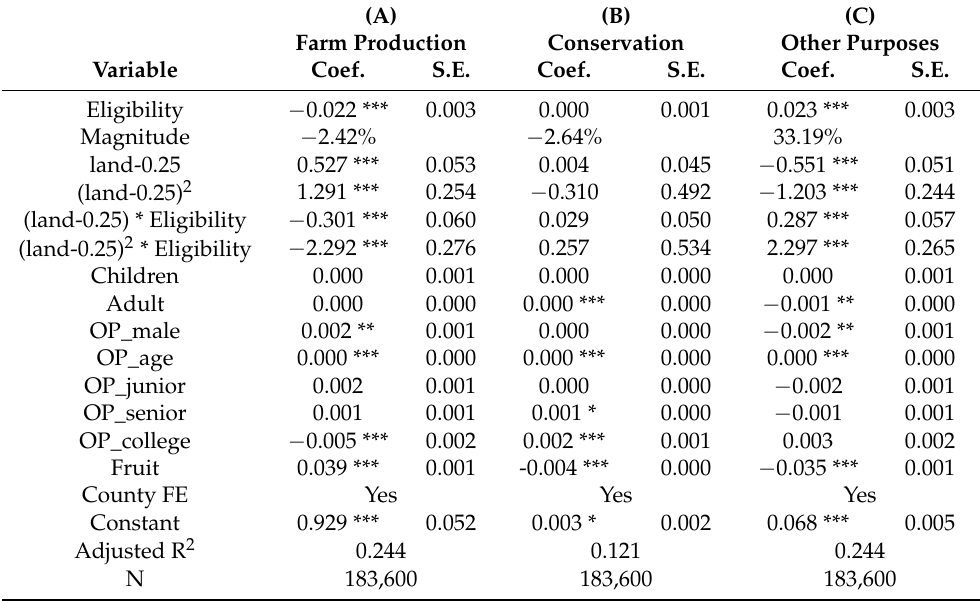
Table 2. Estimation of farmland use